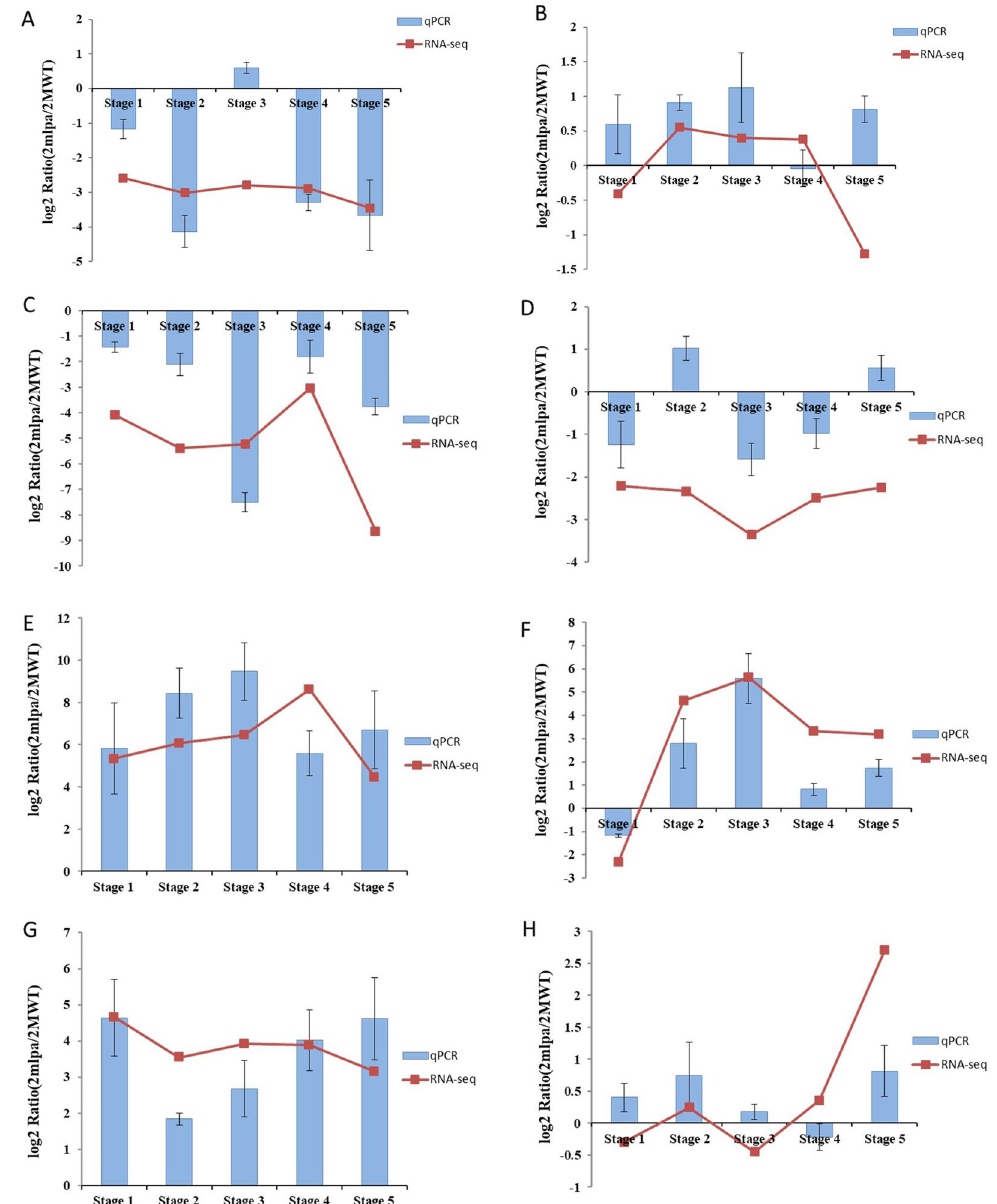
Figure 3. Verification of the RNA-seq results by RT-qPCR. The y-axis represents the log 2 (ratio) ( 2mlpa /2MWT) for ( A ) Glyma.11G238800, ( B ) Glyma.14G072200, ( C ) Glyma.16G065700, ( D ) Glyma.12G210600, ( E